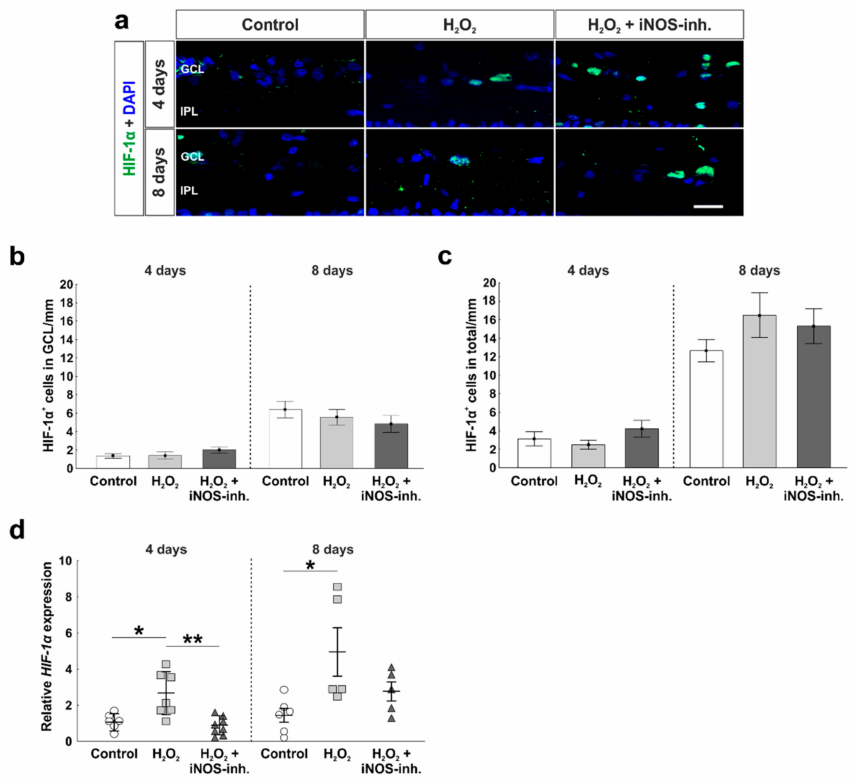
Figure 2. Early inhibition of HIF-1 α gene expression. ( a ) Hypoxic cells were stained using HIF-1 α antibodies (green). Cell nuclei are shown in blue. ( b ) The number of hypoxic cells was not altered in the GCL. ( c ) In the total retina, the number of HIF-1 α + cells was also not altered. ( d ) In contrast, HIF-1 α mRNA expression was increased after oxidative stress at four ( p = 0.014) and eight days ( p = 0.02). Interestingly, the inhibition of iNOS enabled a lower expression of HIF-1 α (four days: p = 0.002), more comparable to the controls. GCL = ganglion cell layer; IPL = inner plexiform layer. ( a – c ) n = 9–10/group and ( d ) n = 5–8/group; scale bars = 20 µ m; values are shown as mean ± SEM for immunohistology and mean ± SD for RT-qPCR. * p < 0.01; ** p <